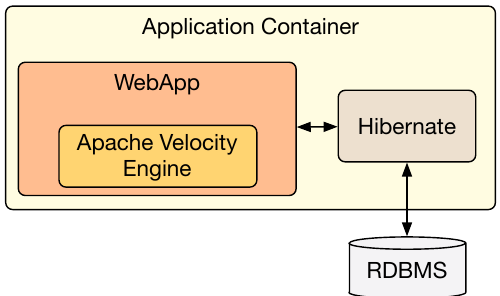
Figure 10. Architecture of the generated web